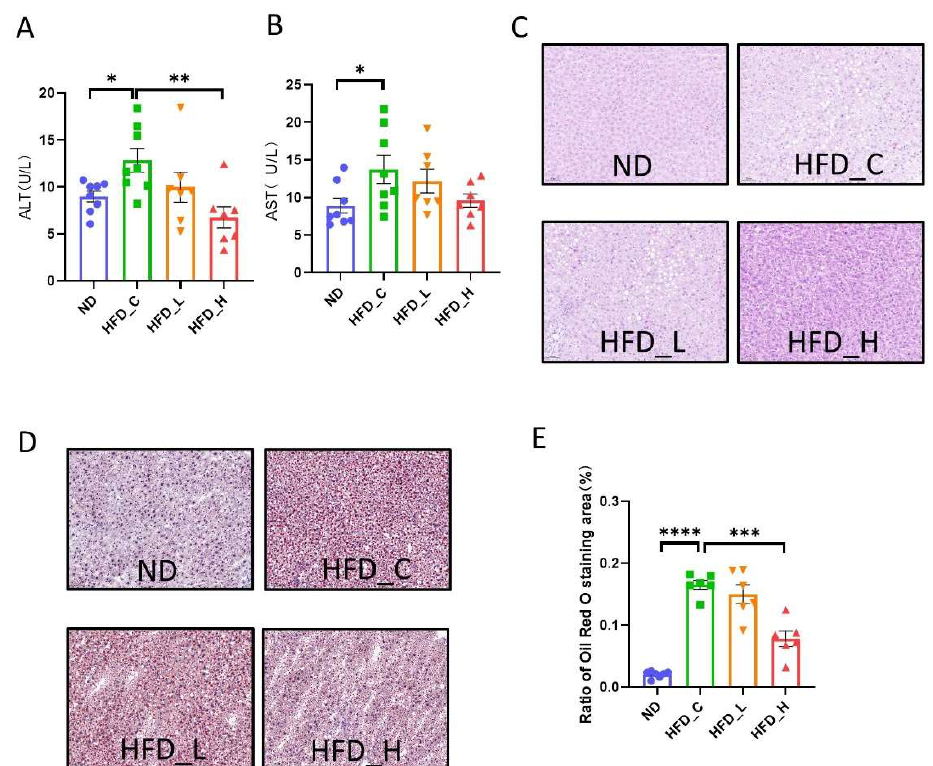
Figure 3. Effects of symbiotic supplementation on fat accumulation and enzyme activity in the liver in rats. Comparative measurements of ( A ) alanine aminotransferase (ALT) and ( B ) aspartate aminotransferase (AST) in the four groups. Representative staining of livers from the four groups with ( C ) H&E and ( D ) oil red O. ( E ) Ratio of oil red O staining area (%). Data are expressed as mean ± SEM; * p < 0.05, ** p < 0.01, *** p < 0.001 and **** p < 0.0001 compared with the HFD_C group.